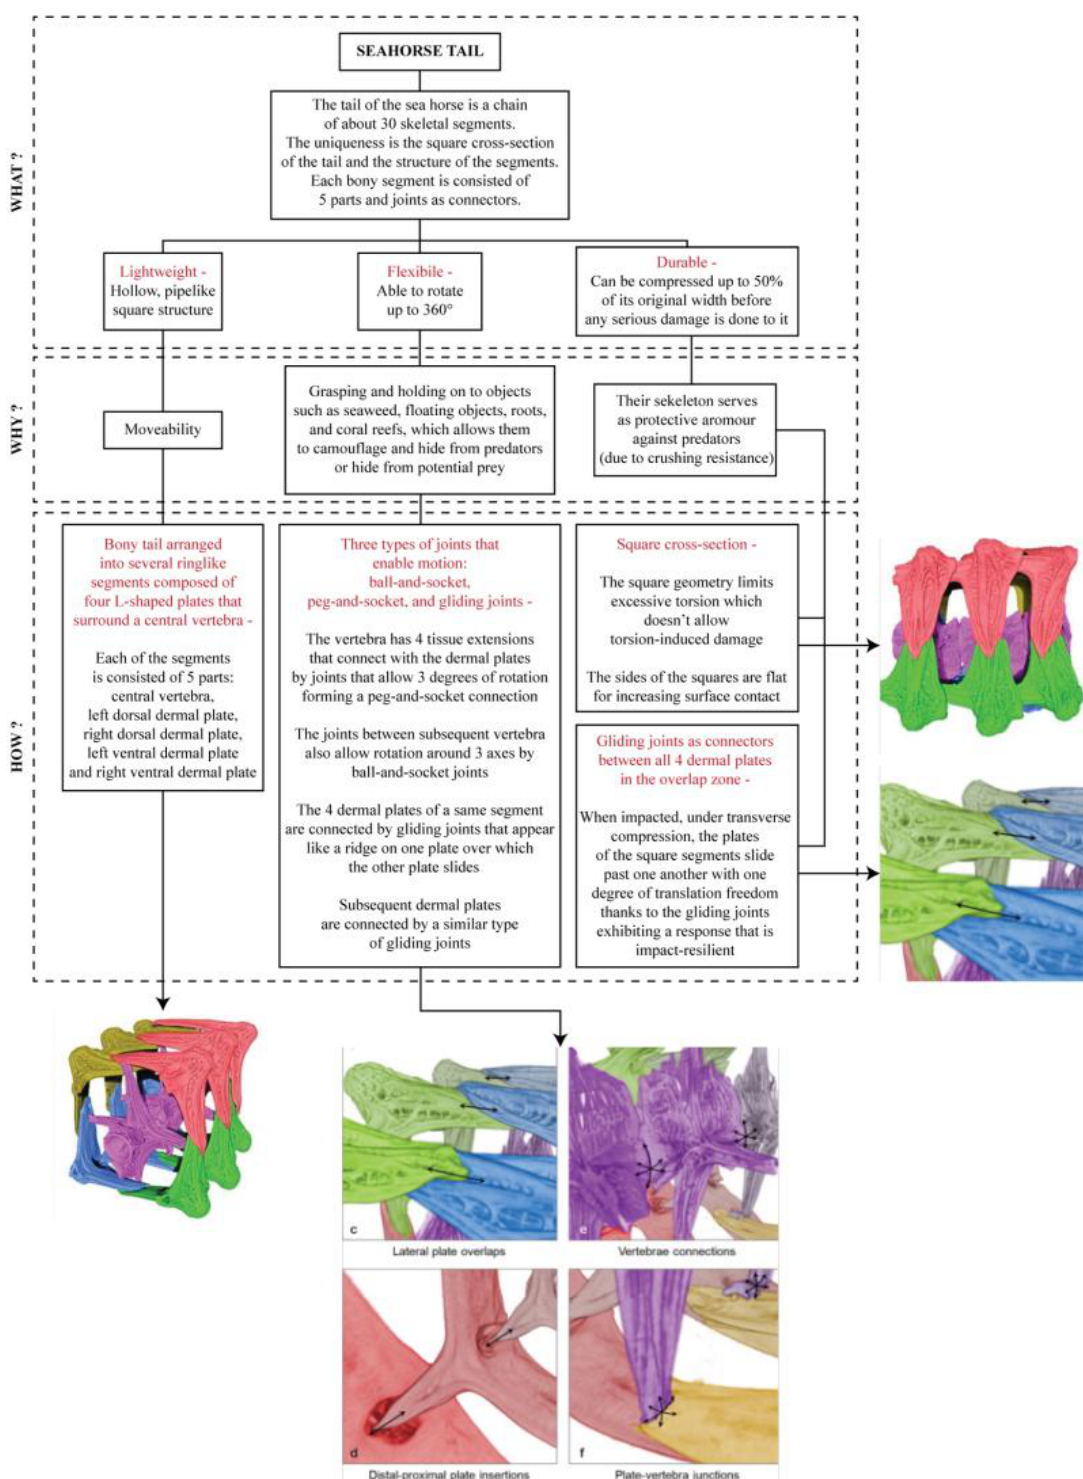
Figure 2. Functional decomposition (Source of used images: Justin Holt, Design and Testing of a Biomimetic Pneumatic Actuated Seahorse Tail Inspired Robot